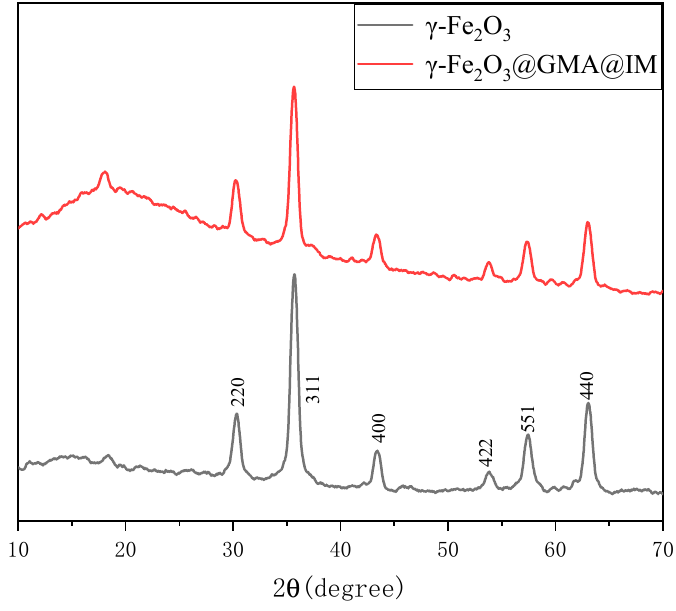
Figure 4. The XRD pattern of γ -Fe 2 O 3 @GMA@IM.